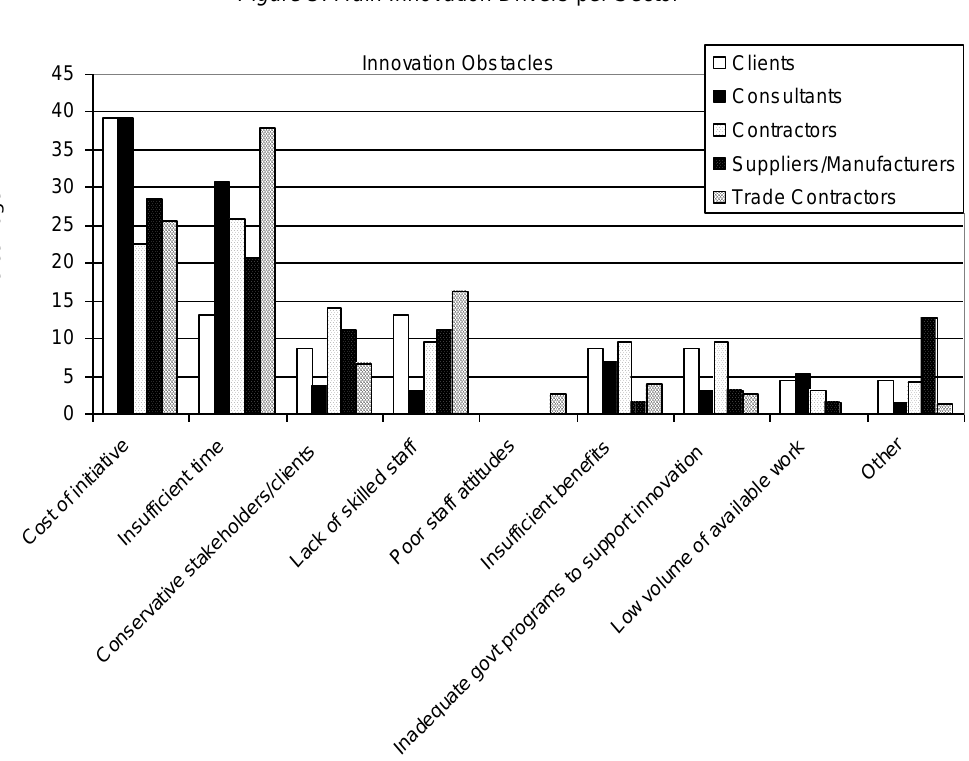
Figure 4 : Main Innovation Obstacles per